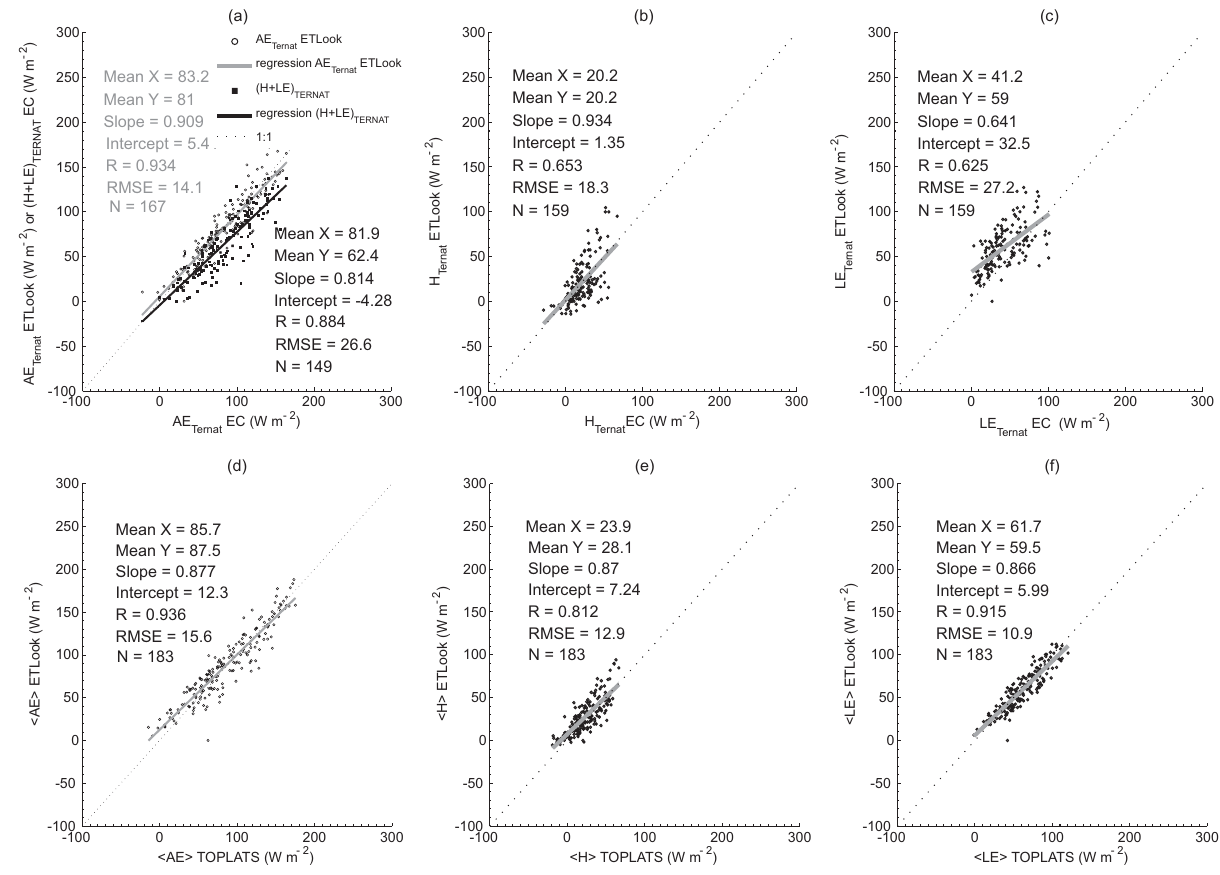
Fig. 4. Comparison for AE, H and LE between ETLook and point-measurements (a) , (b) and (c) , and between ETLook and TOPLATS (d) , (e) and (f)